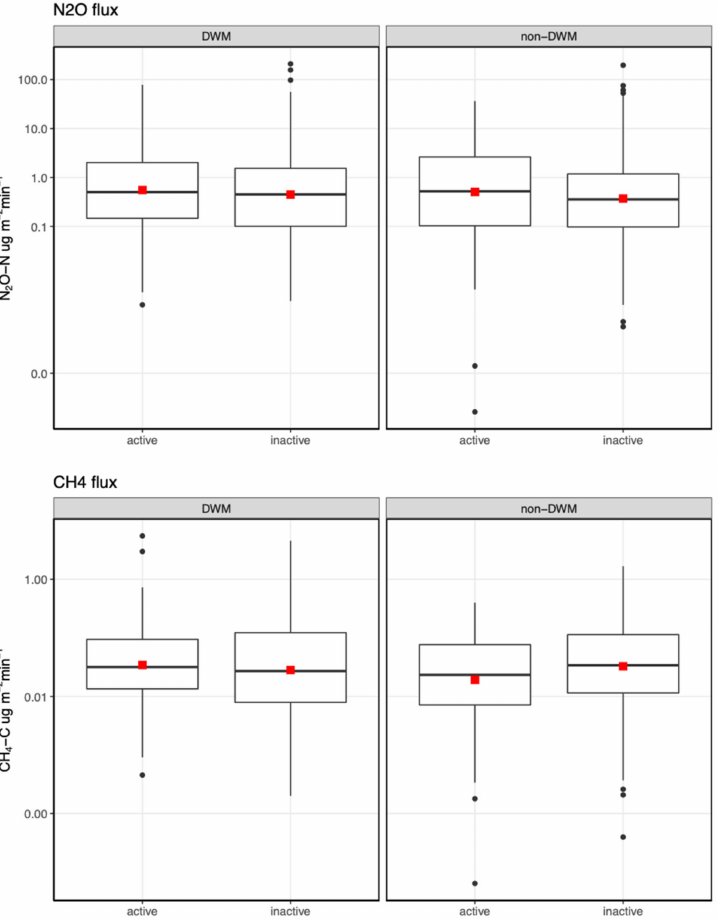
Figure 5. Box plot of gas flux data aggregated by board period and treatment. There were no significant differences ( p > 0.05) between board period in either of the treatments according to the Wilcoxon rank sum test. Red squares represent